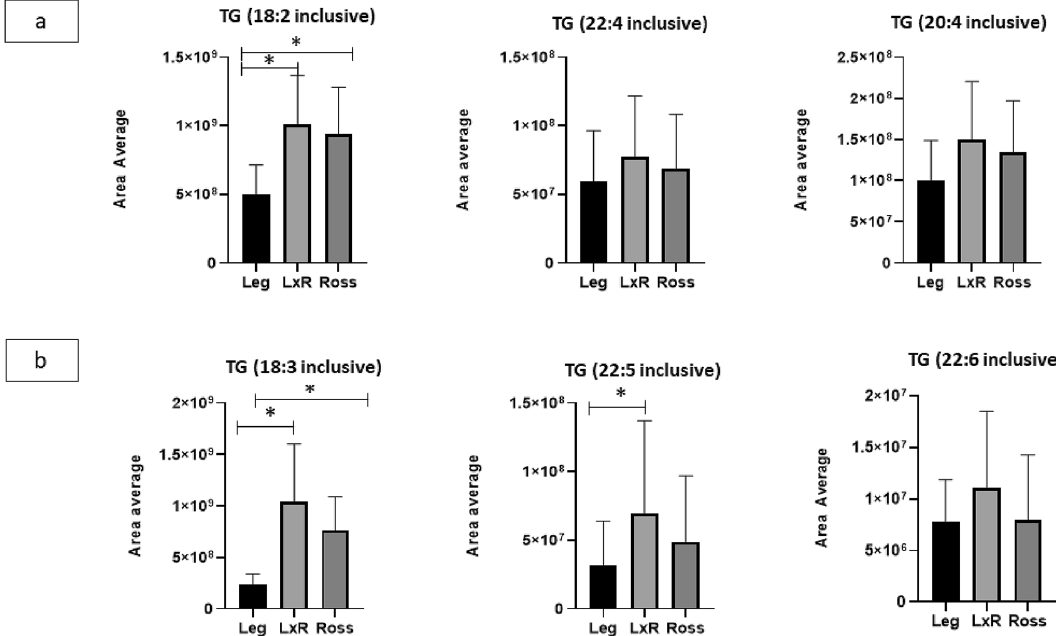
Figure 3. n-6 and n-3 triacylglycerols (TG) of chicken liver: TG, which included specific PUFA ( a ) from n-6 (18:2, LA; 20:4, ARA; 22:4, AdA) and ( b ) from n-3 series (18:3, ALA; 22:5, DPA; 22:6, DHA). Leg: Leghorn genotype; LxR: crossbreed, Ross: Ross 208 genotype. *P < 0.05 (post hoc Tukey’s test).